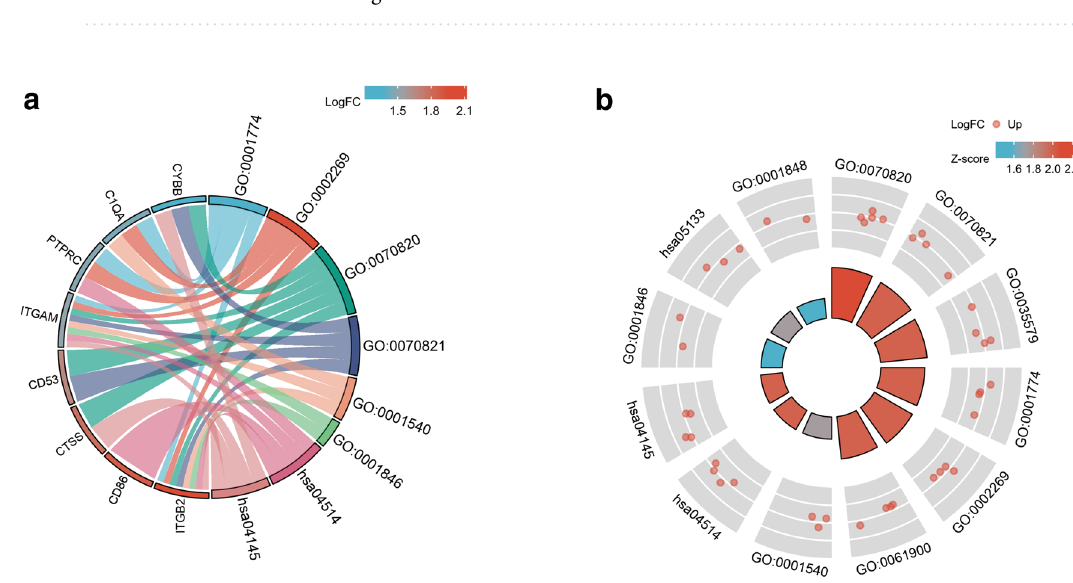
Table 1. The details of the hub genes.